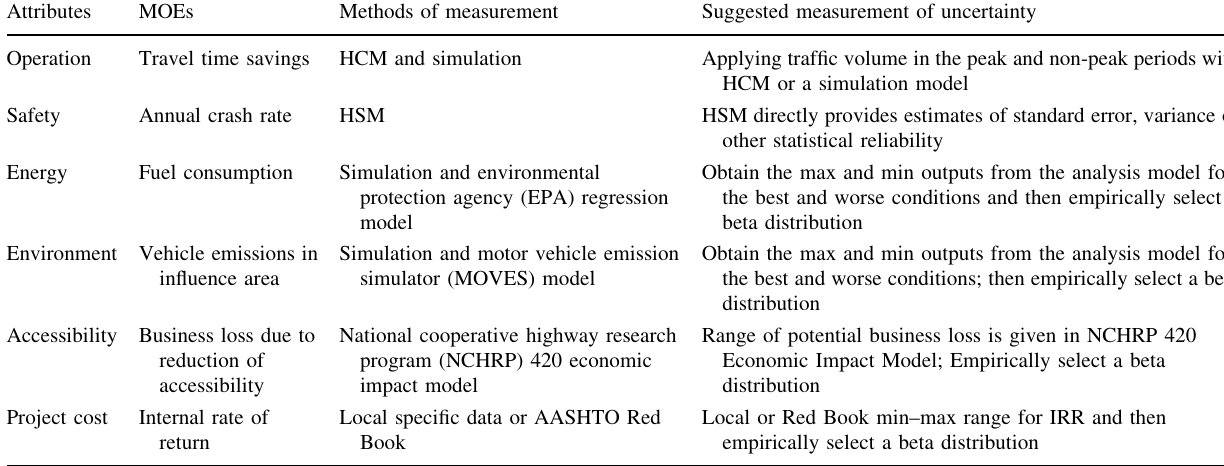
Table 2 Main indicators and measures of their uncertainties Attributes